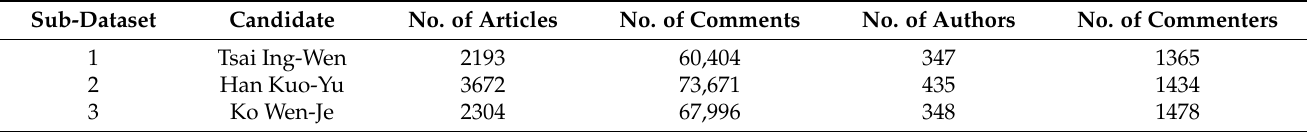
Table 1. A summary of our